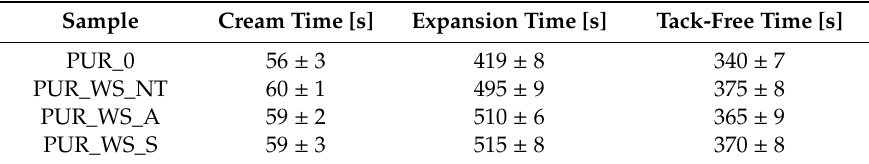
Table 4. Processing times of PUR foams.